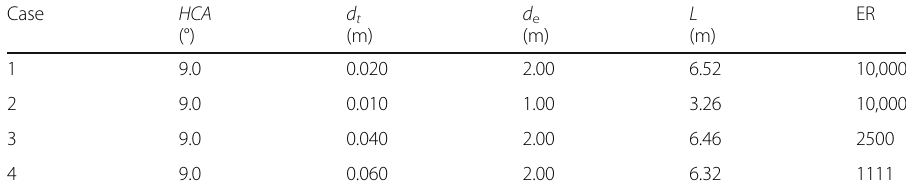
Table 2 Geometrical parameters based on the FD-21 nozzle Case HCA